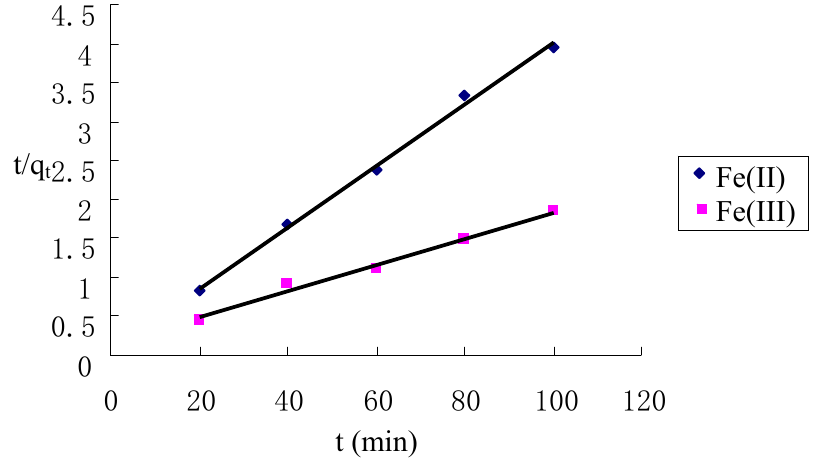
Figure 6. Pseudo second-order kinetic plots for the adsorption of Fe(II) and Fe(III).